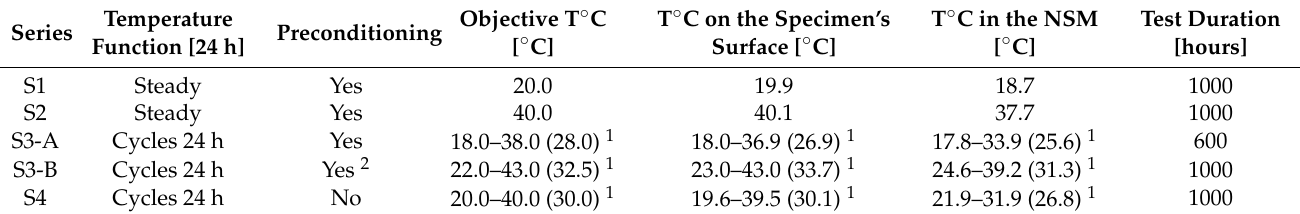
Table 2. Details of experimental series.